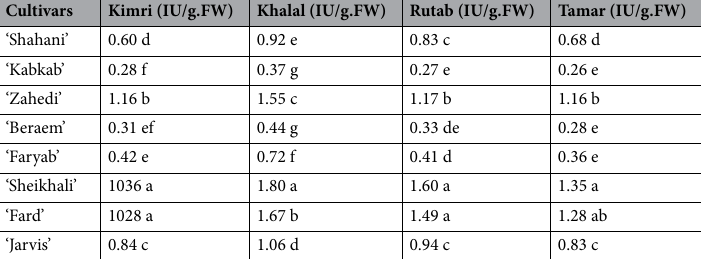
Table 11. Invertase enzyme activity of ‘Piarom’ date fruit in kimri, khalal, rutab and tamar stages after pollination with eight pollinating cultivars. Different letters within columns indicate significant differences according to Duncan’s multiple range test (p <